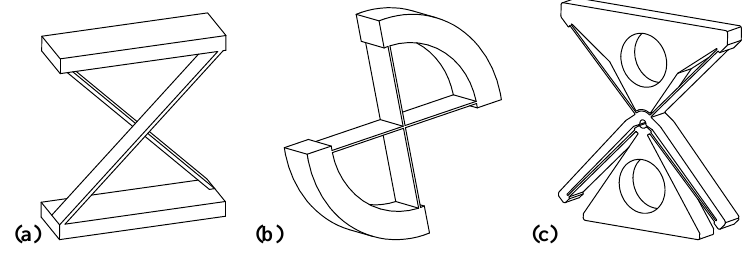
Fig.1 Leaf-Type Flexure joints: (a) A cross-axis pivot; (b) A cartwheel hinge; (c) An ADLIF